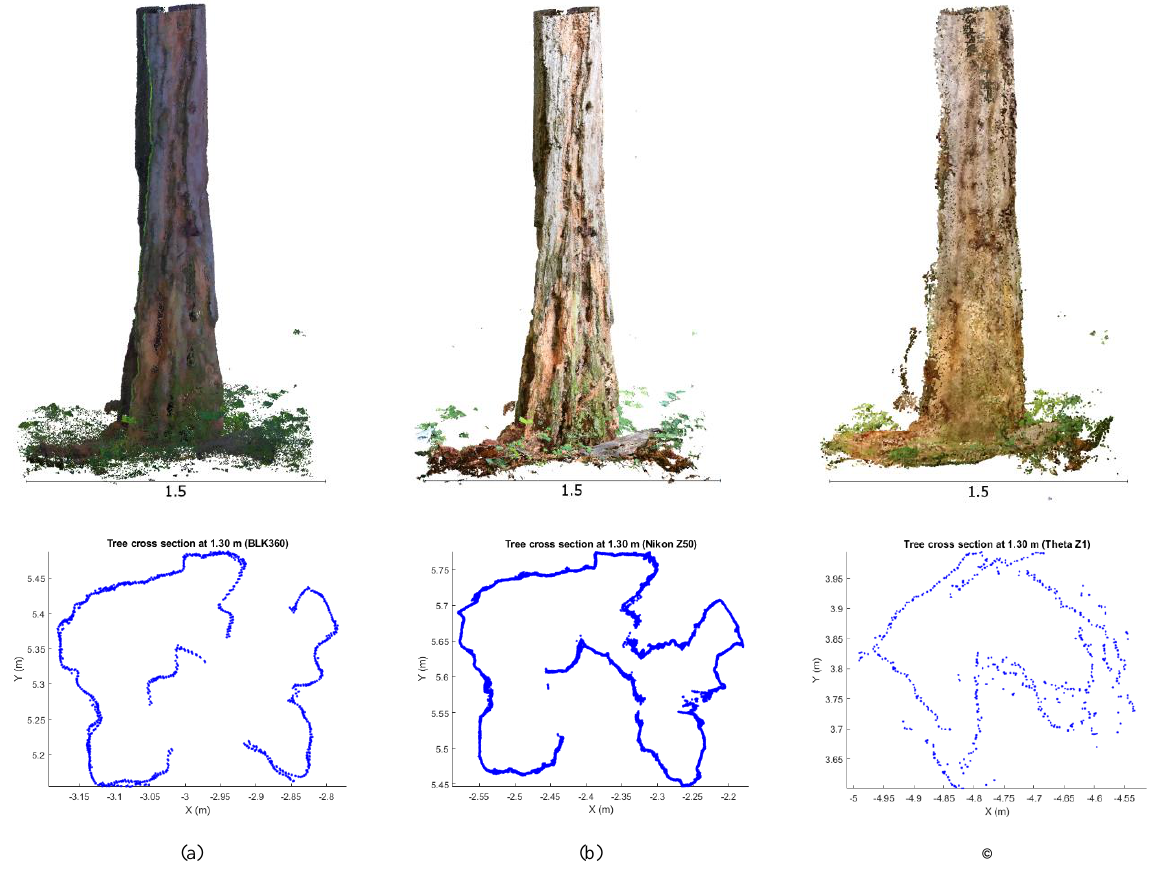
© Figure 6. Cleaned dense point cloud of “Tree 01” generated by (a) BLK360 TLS, (b) close-range photogrammetry using Nikon Z50, and (c) spherical photogrammetry using Ricoh Theta Z1. The lower figures show the respective cross-sections at a 1.3 m height and 10 cm thickness used for the DBH computation analysis.